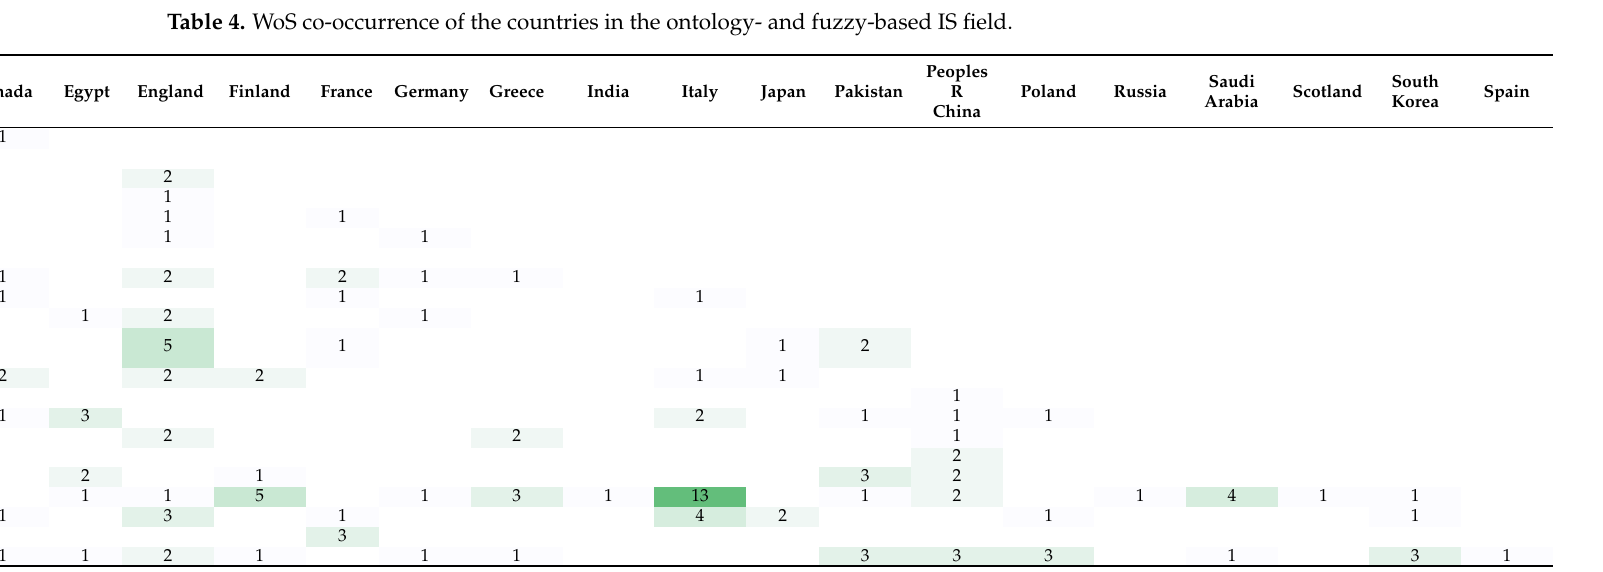
1 Note that countries are named as they appear in